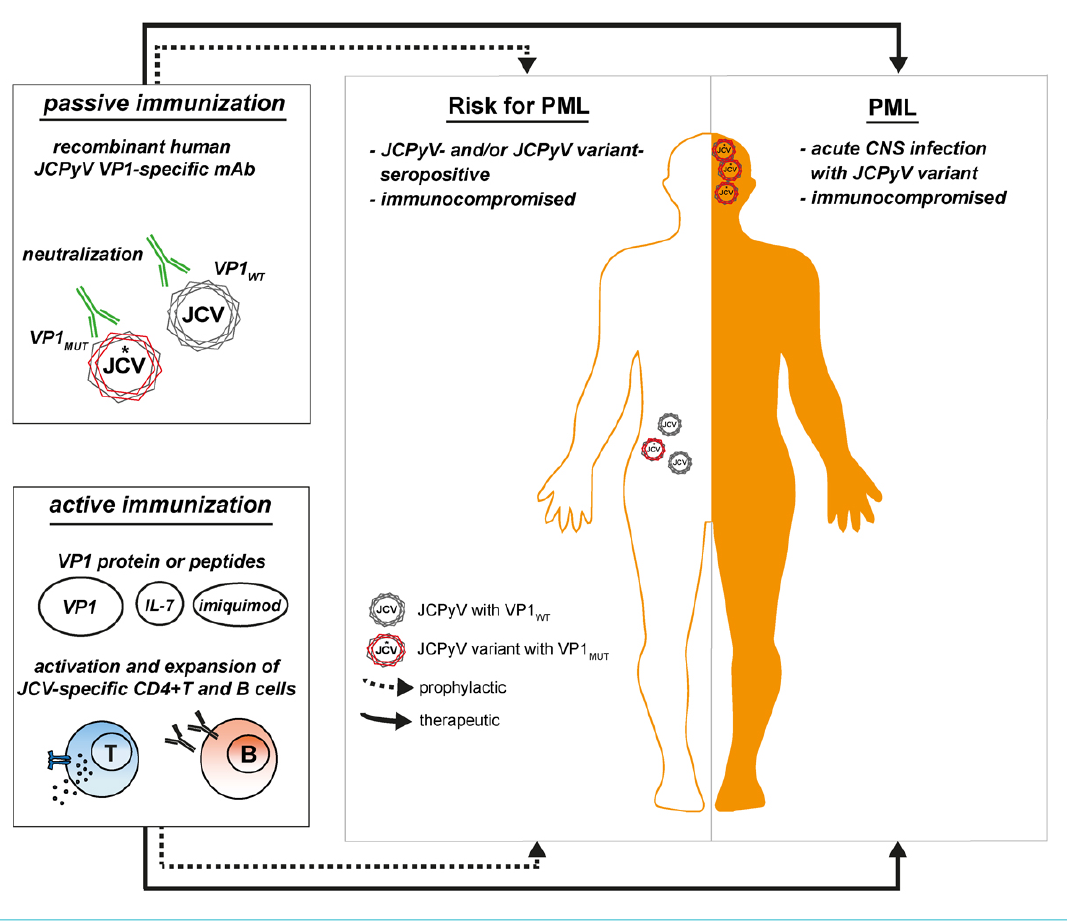
Figure 2: Overview of the active and passive immunization approaches for the prophylactic and therapeutic treatment of PML. These novel vaccination approaches are considered for both patients with PML and immunocompromised, JCPyV-positive patients at risk of developing PML. Passive immunisation involves administering broadly neutralising JCPyV VP1-specific recombinant antibodies. The latter are expected to provide protection from and neutralisation of neurotropic pathological JCPyV VP1 variants. The active immunisation strategy implies a direct boost of adaptive immune responses specific for JCPyV variants in patients by vaccinating with whole protein or peptides of the major capsid protein VP1 in combination with an adjuvant (e.g., imiquimod) and supporting cytokines (e.g.. interleukin-7). The latter will lead particularly to the activation and expansion of JCPyV-specific CD4 + effector T cells and antibody-producing B cells, which will confer a broad protection from pathological JCPyV infection to the